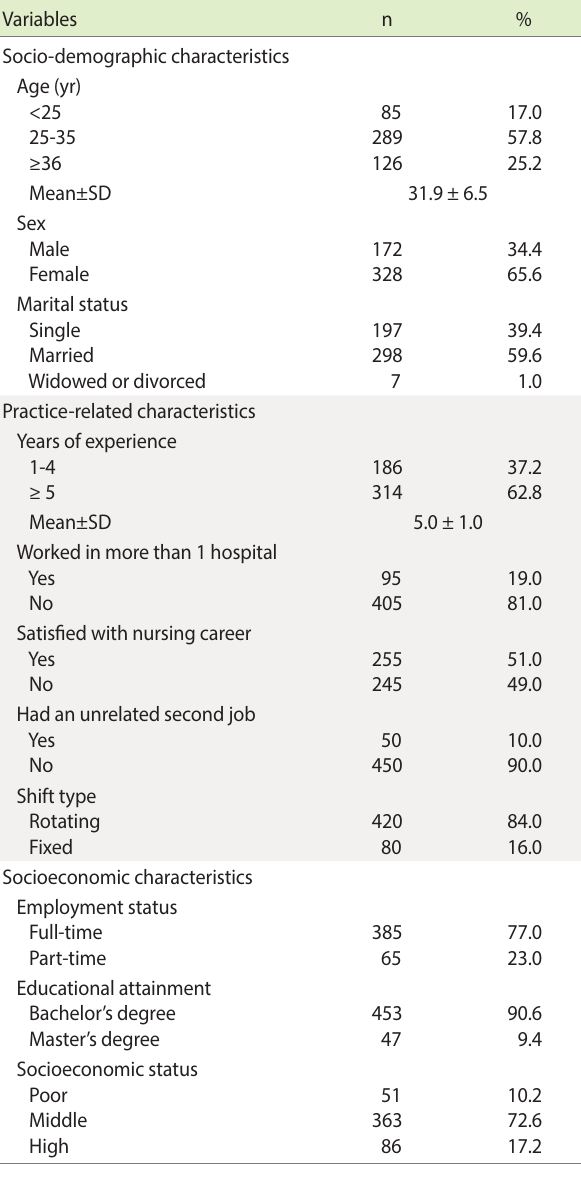
Table 1. Demographic, practice-related, and socioeconomic char ac- teristics of nurses in Kermanshah, western Iran (n=500)